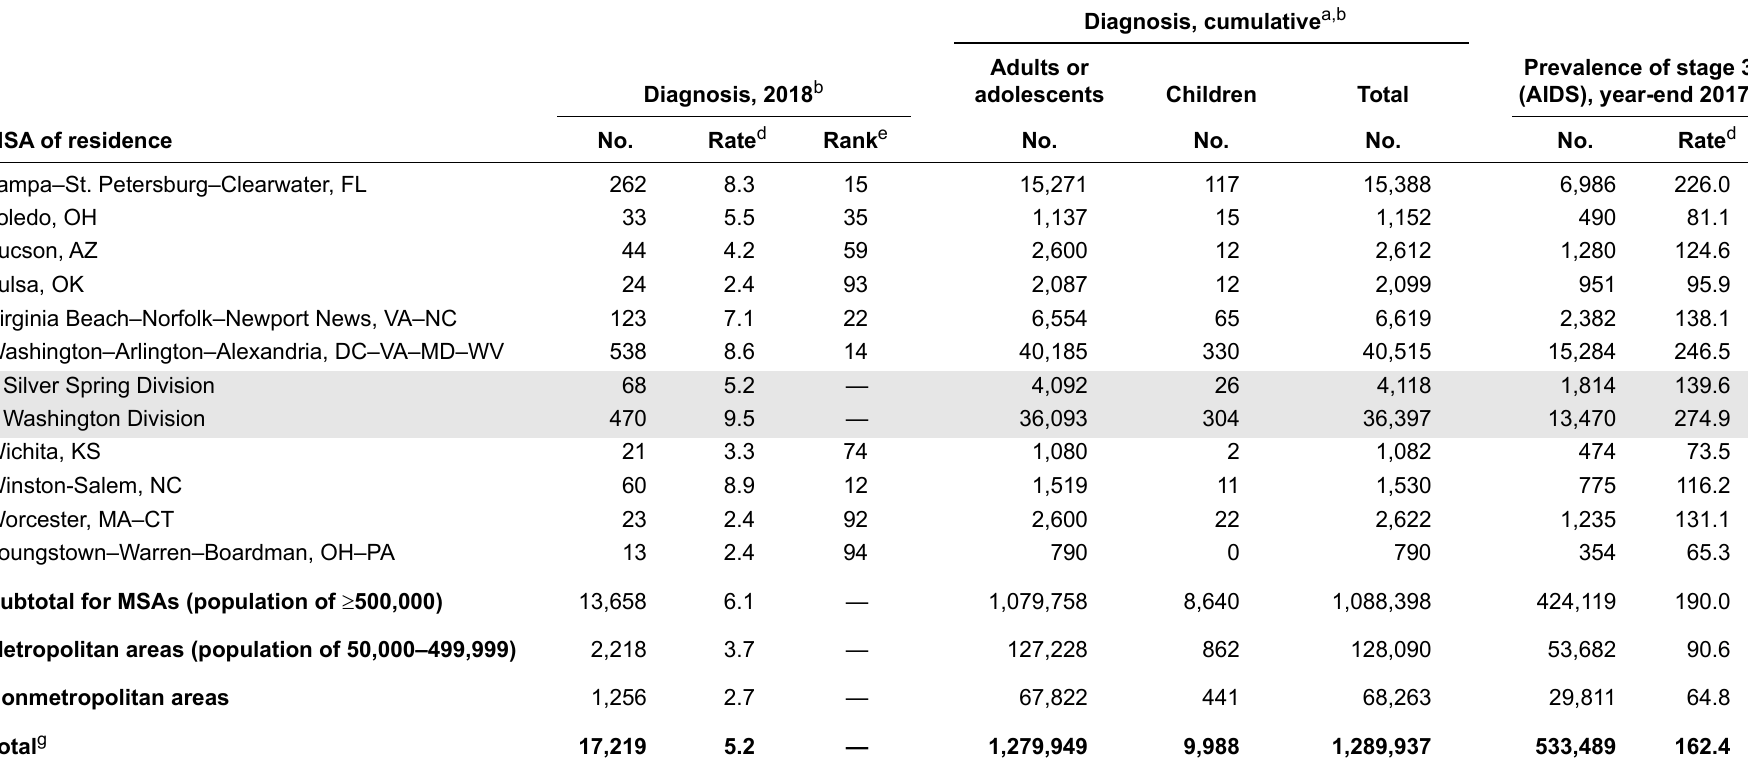
Table 31. Stage 3 (AIDS), 2018 and cumulative, and persons living with diagnosed HIV infection ever classified as stage 3 (AIDS) (prevalence), year-end 2017, by metropolitan statistical area of residence—United States and Puerto Rico